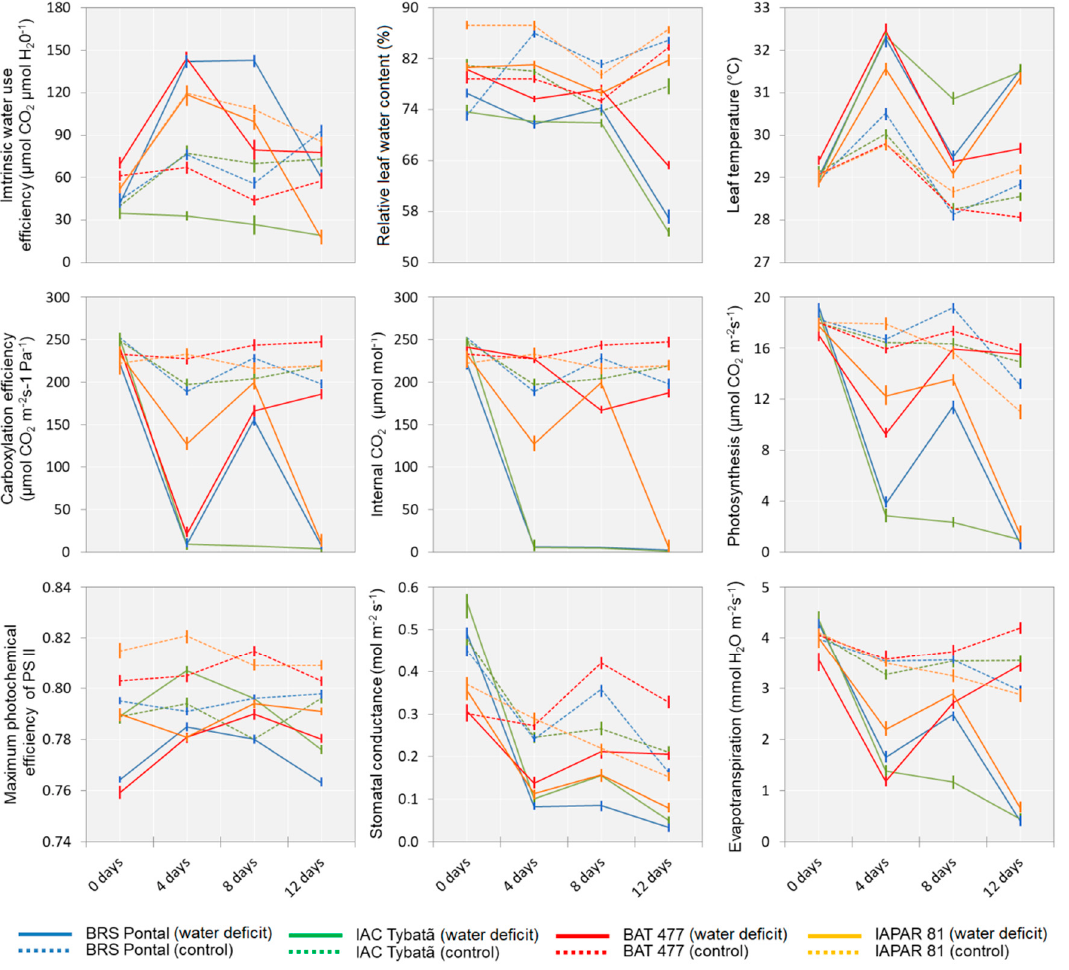
Figure 2. Physiological traits of common bean cultivars measured for 0, 4, 8, and 12 days, under control and water-deficit conditions.